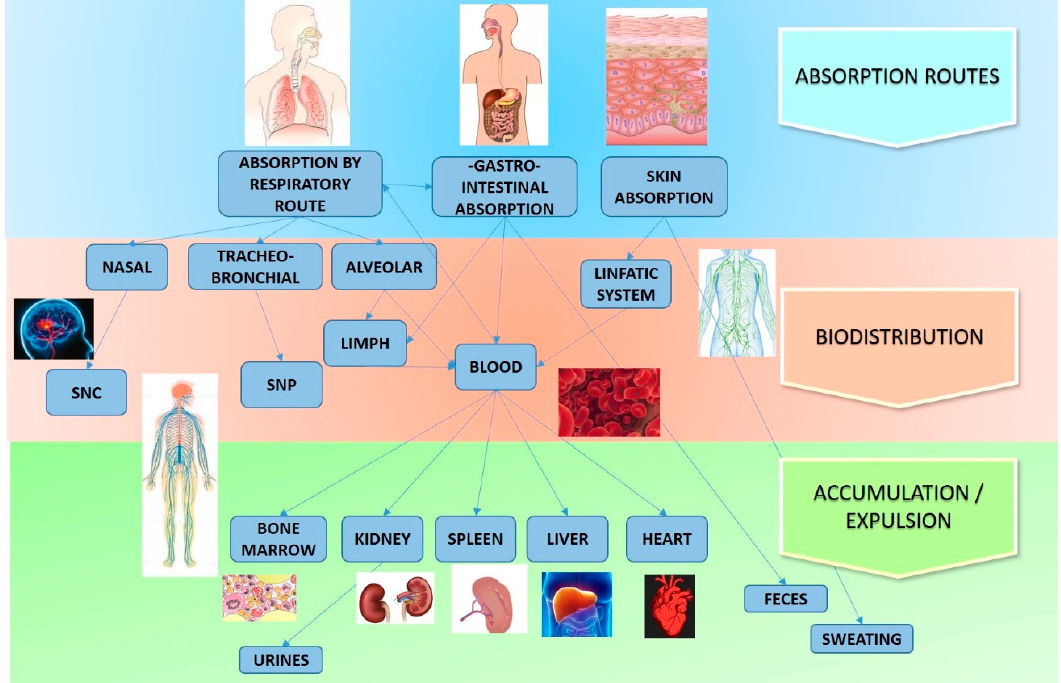
Figure 4. ZnO nanostructure (NStr) interaction mechanisms with the organism (SNC: central nervous system; SNP: peripheral nervous system).